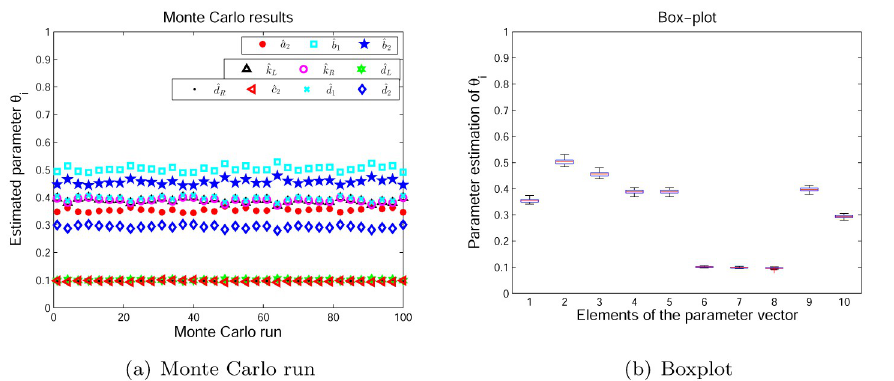
Fig 9. Monte Carlo run. (a) Monte Carlo run. (b) Boxplot.